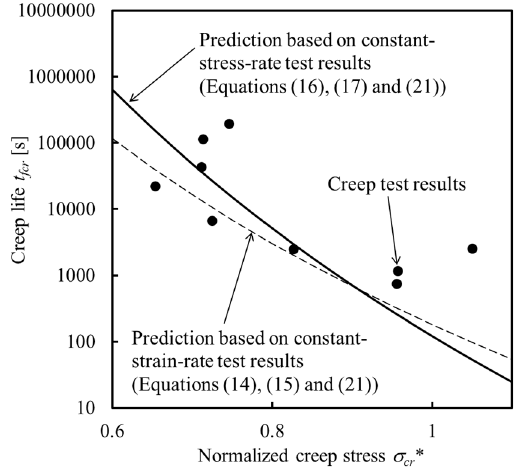
Figure 12. Creep life t fcr versus normalized creep stress σ cr * in creep tests.